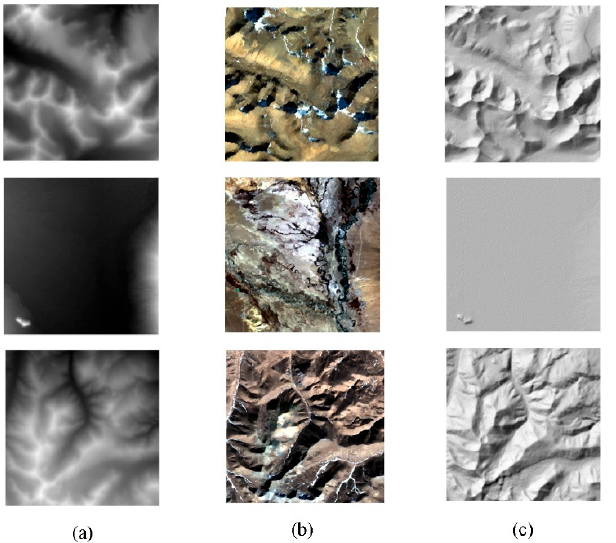
Figure 1. Textures of the targeted landforms in different data. ( a ) DEM texture; ( b ) Landsat-8 texture; ( c ) Hillshade.